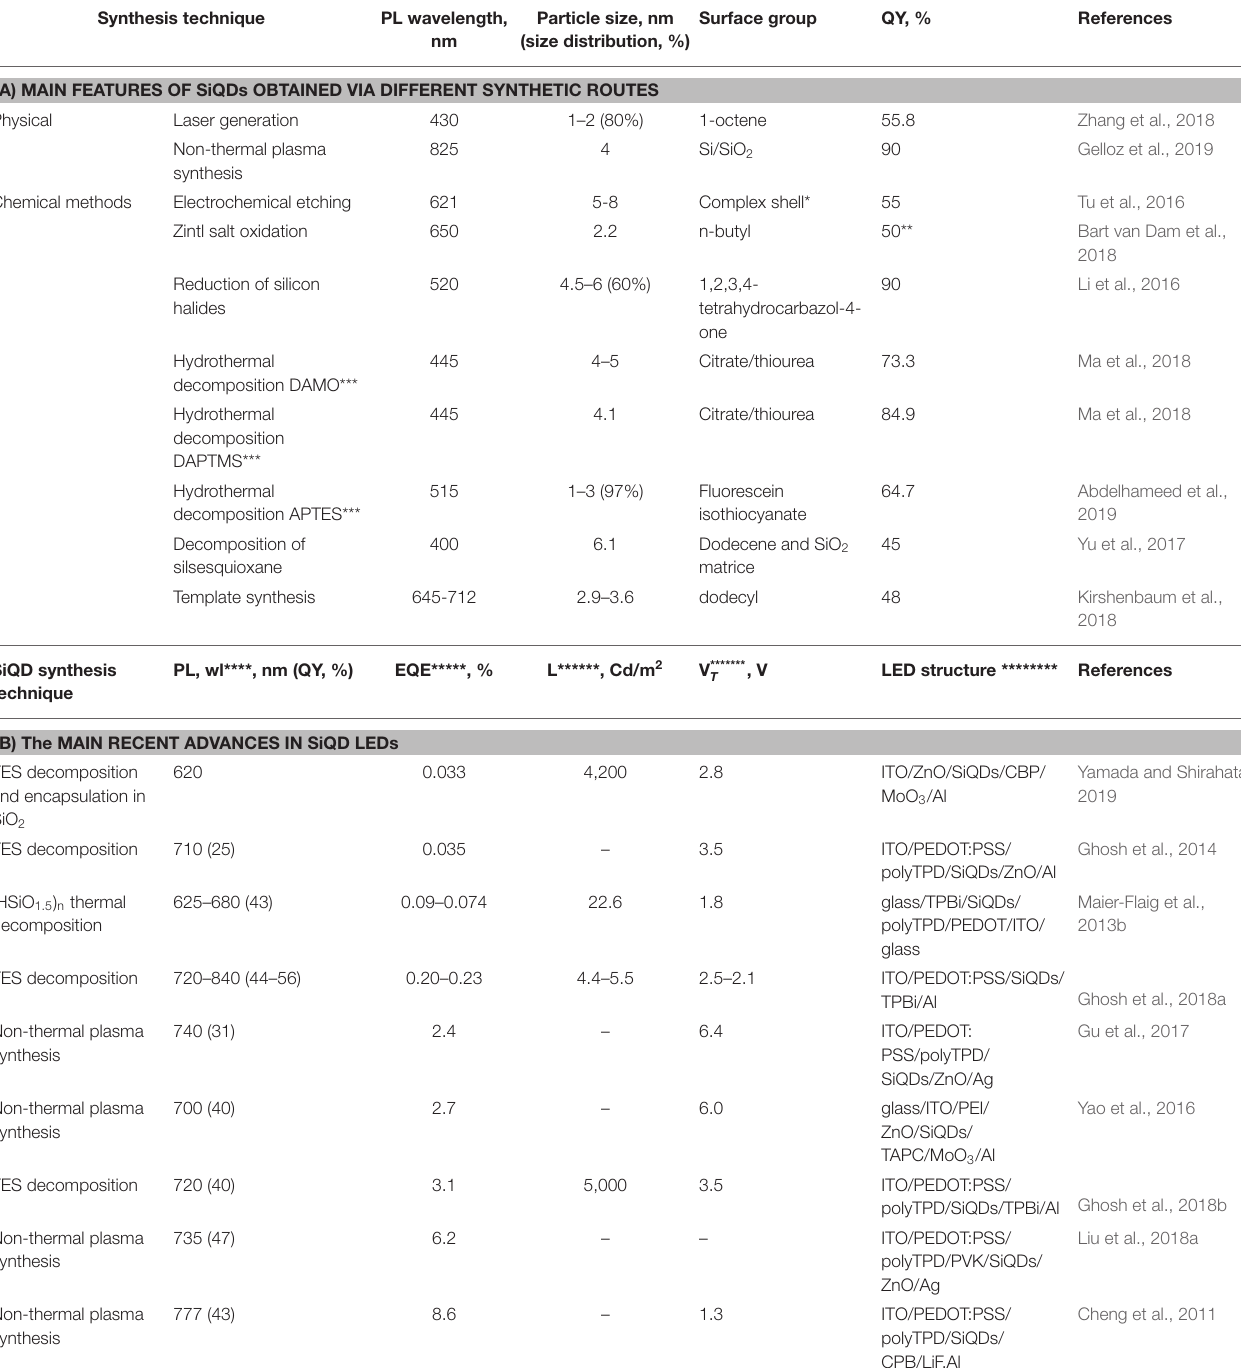
TABLE 1 | Main features of SiQDs obtained via different synthetic routes and the main recent advances in SiQD LEDs. Synthesis